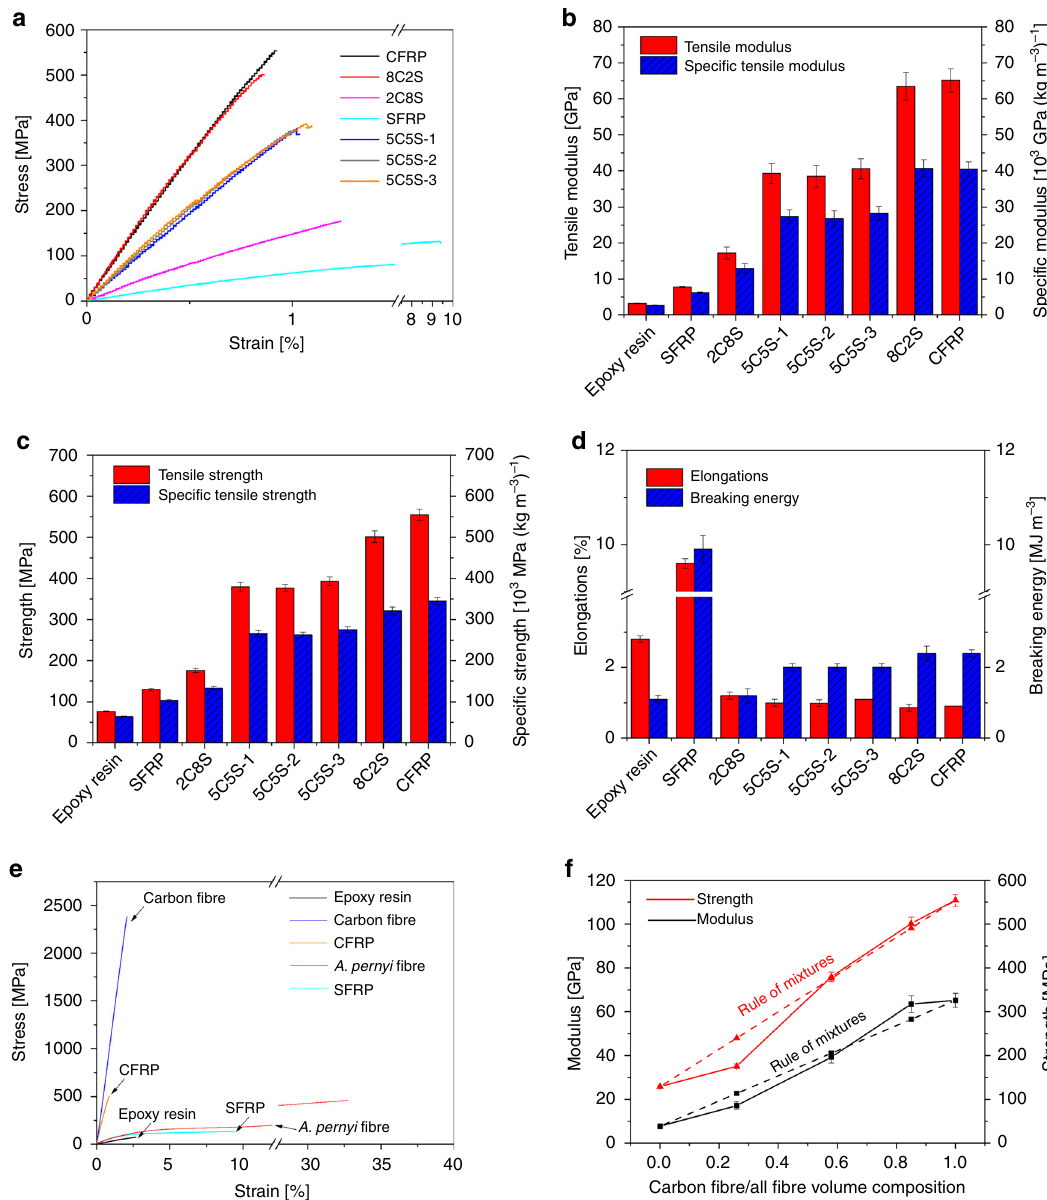
Fig. 2 Tensile properties of composites. a Typical tensile engineering stress – strain curves, b modulus and speci fi c tensile modulus, c strength and speci fi c tensile strength, and d elongation and breaking energy. Note that the breaking energy is calculated as the area under the stress – strain curve and the unit is converted from MPa to MJ m − 3 for easy comparison with the literature. e Direct comparison of tensile stress – strain behaviour of pure epoxy resin, two reinforcement fi bres, 69 vol.% CFRP and 51 vol.% SFRP. f Comparison of the tensile modulus and strength of the HFRP composites with increasing silk volume composition. The dashed lines indicate the expected values from the rule of mixtures (Eq. (1)). The silk volume compositions of 8C2S, 5C5S and 2C8S were, respectively, calculated as 15%, 42% and 74%. The error bars represent the standard deviation of measured